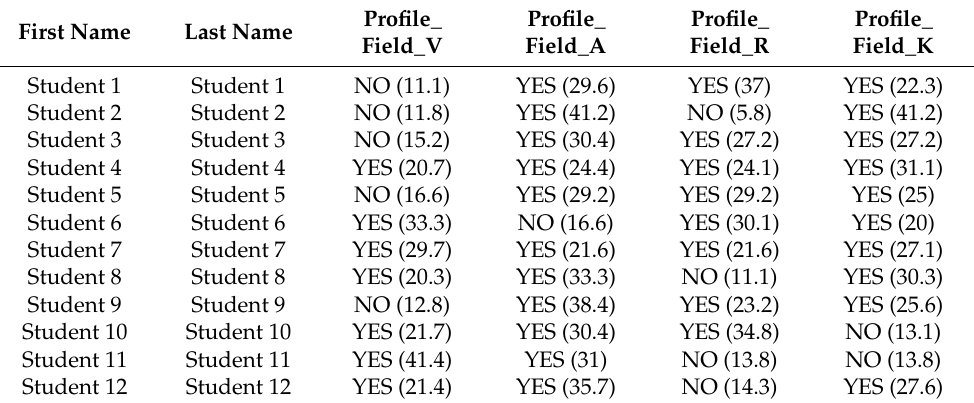
Table 1. Examples of VARK attributes in students’ portfolios in the test